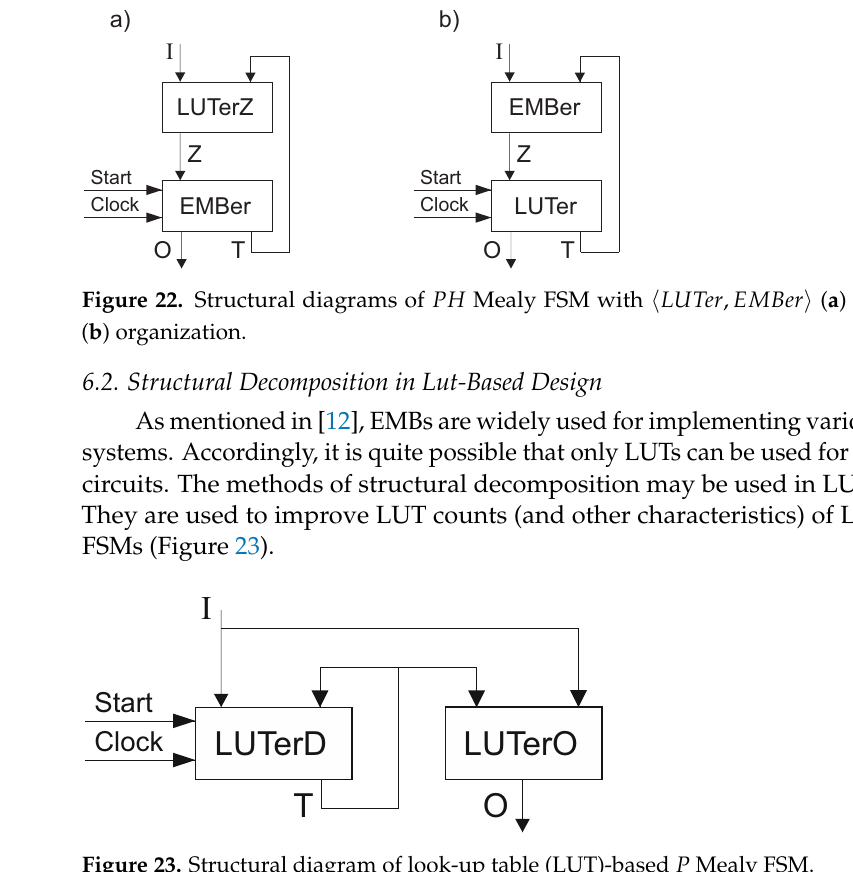
Figure 23. Structural diagram of look-up table (LUT)-based P Mealy FSM.